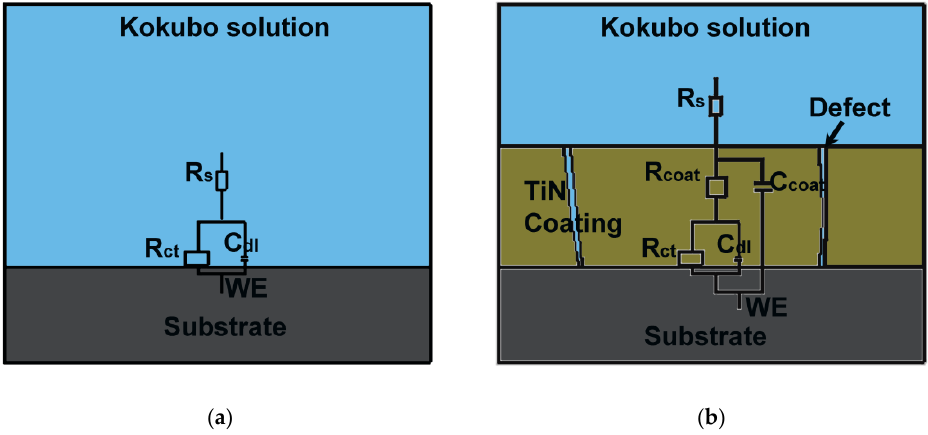
Figure 9. Schematic diagrams representing phenomena that occurred when ( a ) uncoated and ( b ) coated samples were immersed in Kokubo solution, along with their equivalent circuits. Table 1. Summary of output data from nanoindentation tests for ultrasonic treated samples at 16 kHz for different exposure times (extreme high PVD condition).